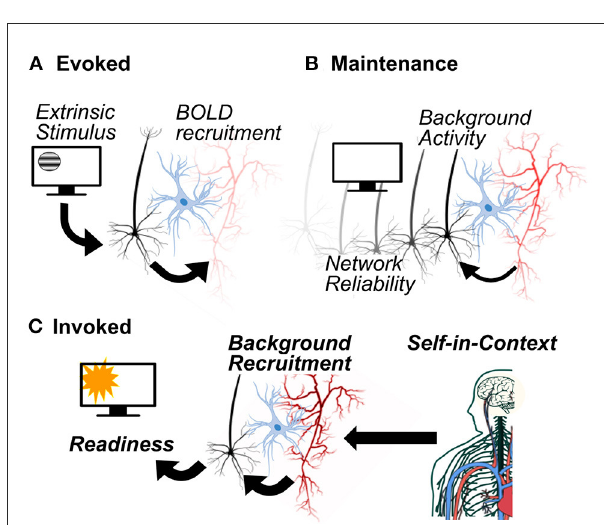
FIGURE2 Three types of neurometabolic work to support cognition. Evoked work (A) is characterized by the recruitment of metabolic activity in response to stimulus driven neural activity. Maintenance work (B) does not depend on the presence of a stimulus: metabolic processes support neuronal background activity that, in turn, enables reliable synaptic network structure. Invoked work (C) anticipates the need for metabolic activity on the basis of the self-in-context, recruiting background activity for cognitive and behavioral